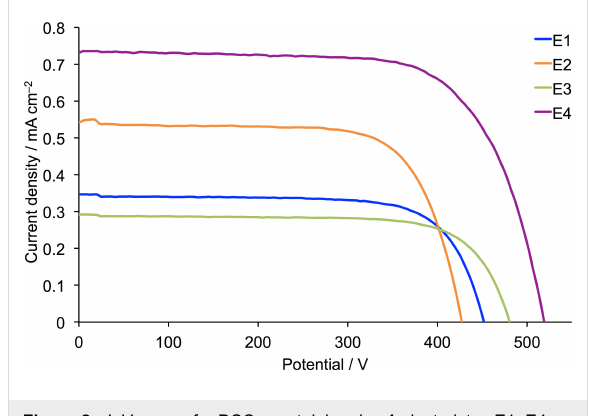
Figure 1: J–V curves for DSCs containing dye 1 and electrolytes with MPN (E1, E2) and MeCN (E1a, E2a) as solvents.